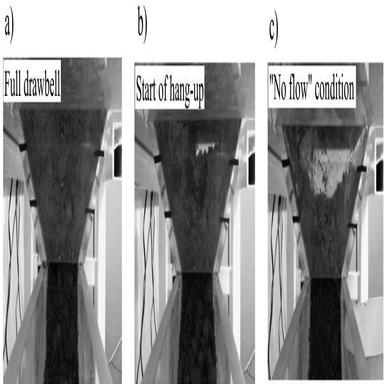
Evolution of a "no flow" condition - cross-sectional view of the drawbell.